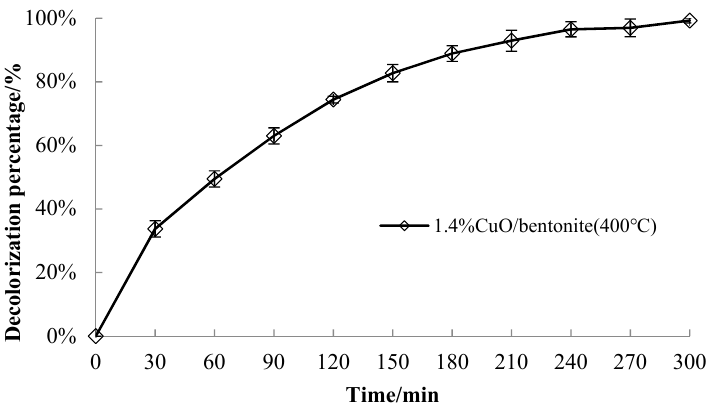
Figure 6. Effect of irradiation time on the catalytic activity of the catalyst